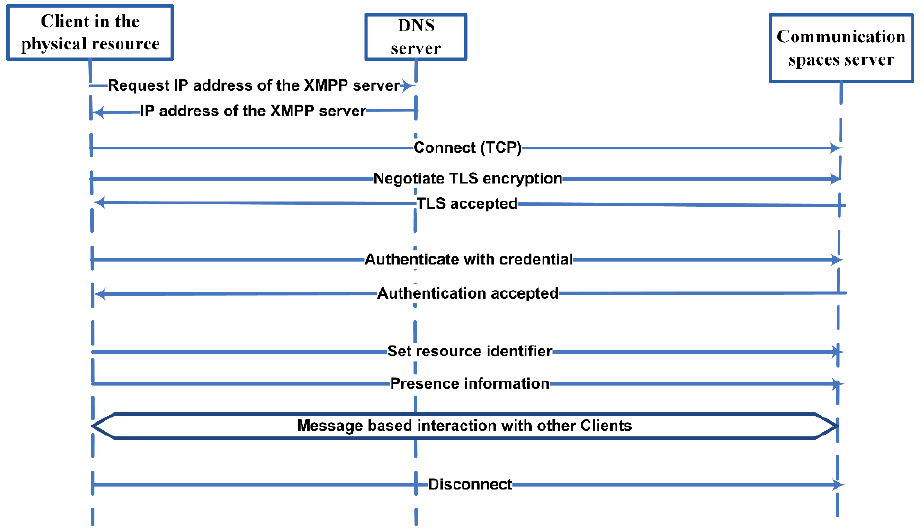
Figure 13. Connecting and presence registration of the physical resources. XMPP, extensible messaging and presence protocol; TLS, transport layer security.